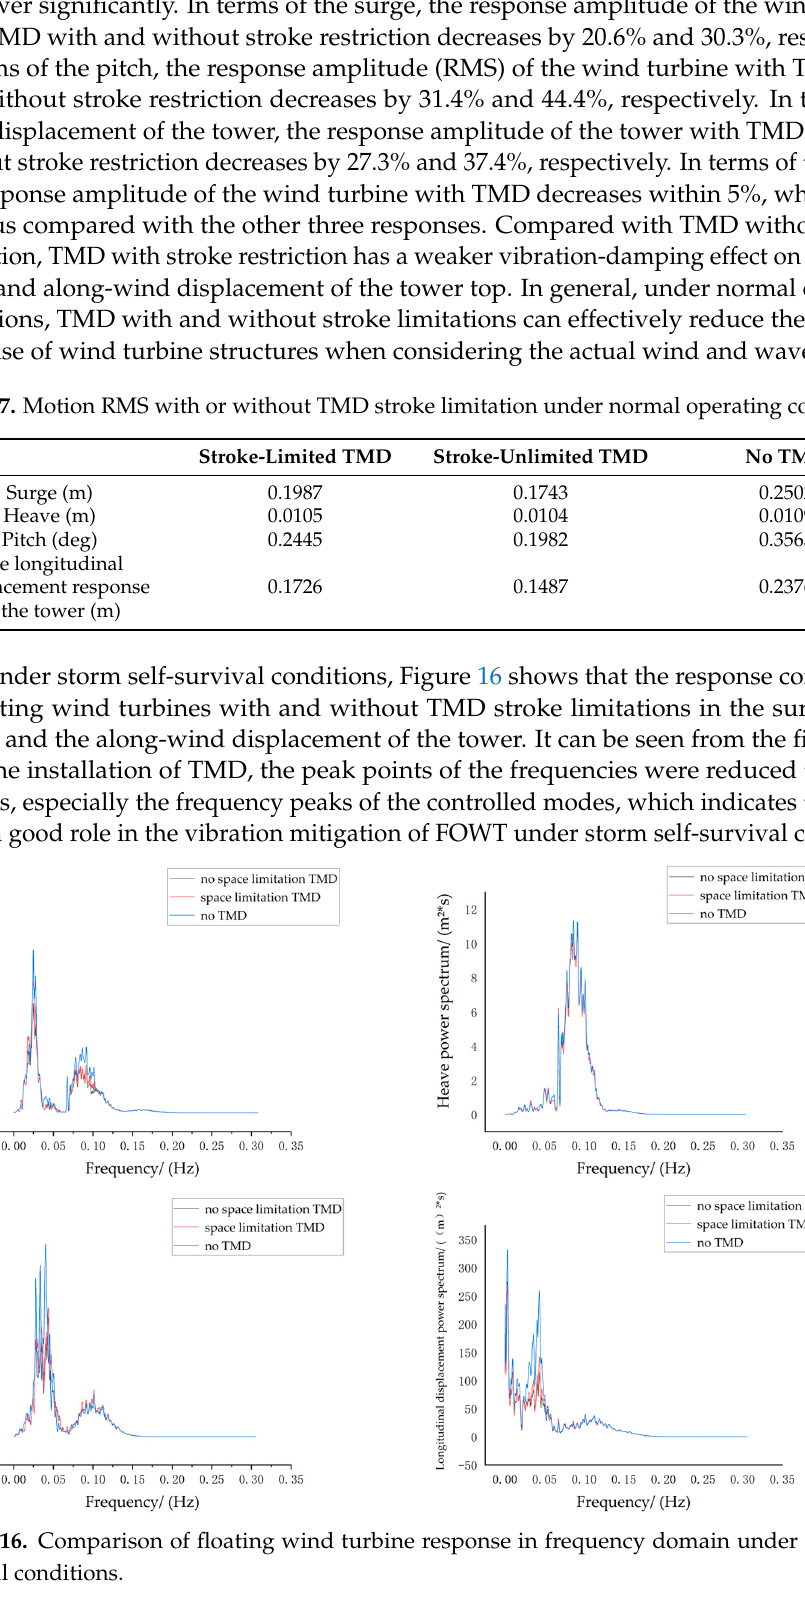
Table 17. Motion RMS with or without TMD stroke limitation under normal operating conditions.